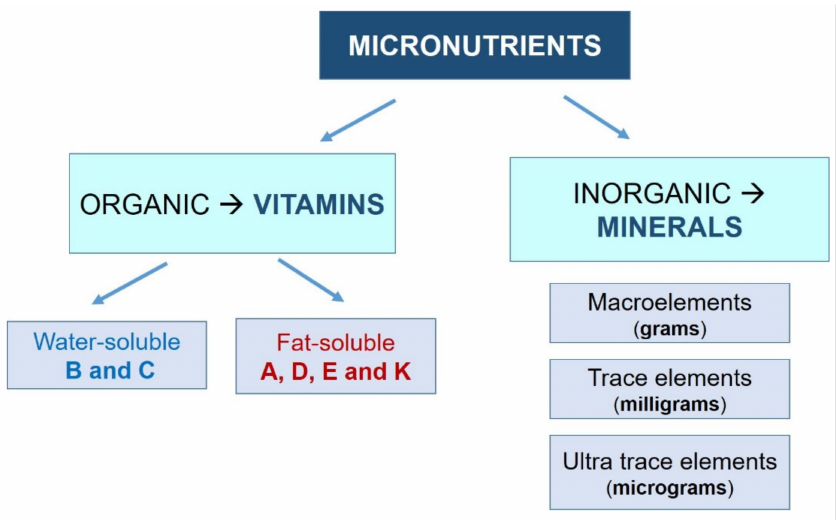
Figure 1. Classification system for the different